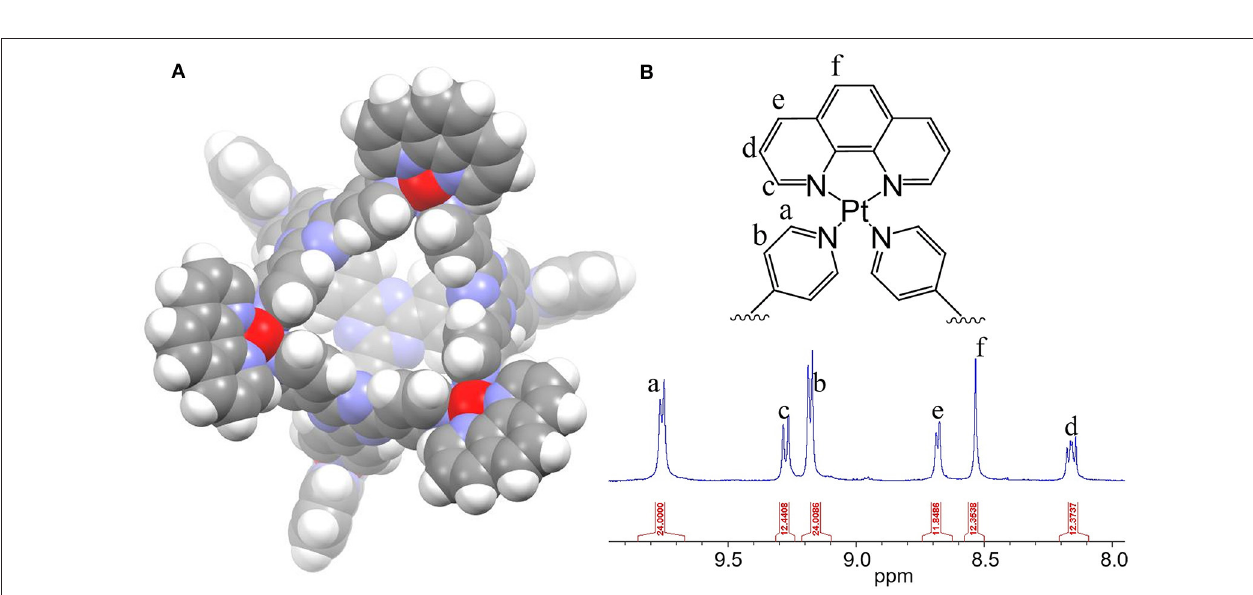
FIGURE 1 | (A) The 3D model of the Pt 6 L 4 metal-organic cage (1) and (B) its 1 H NMR spectrum in DMSO-d 6 .